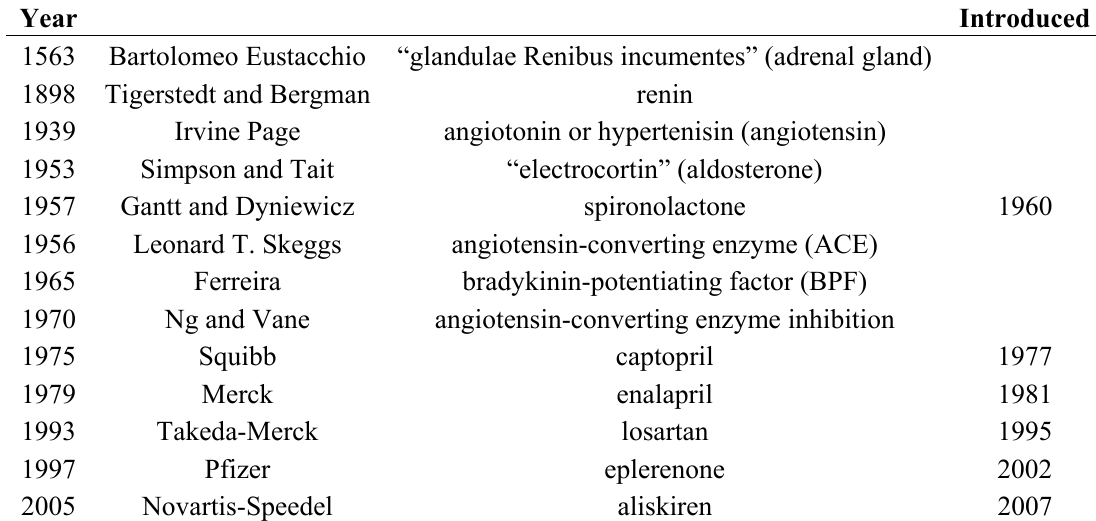
Table 1. History of discovery and development of RAAS and their blockers